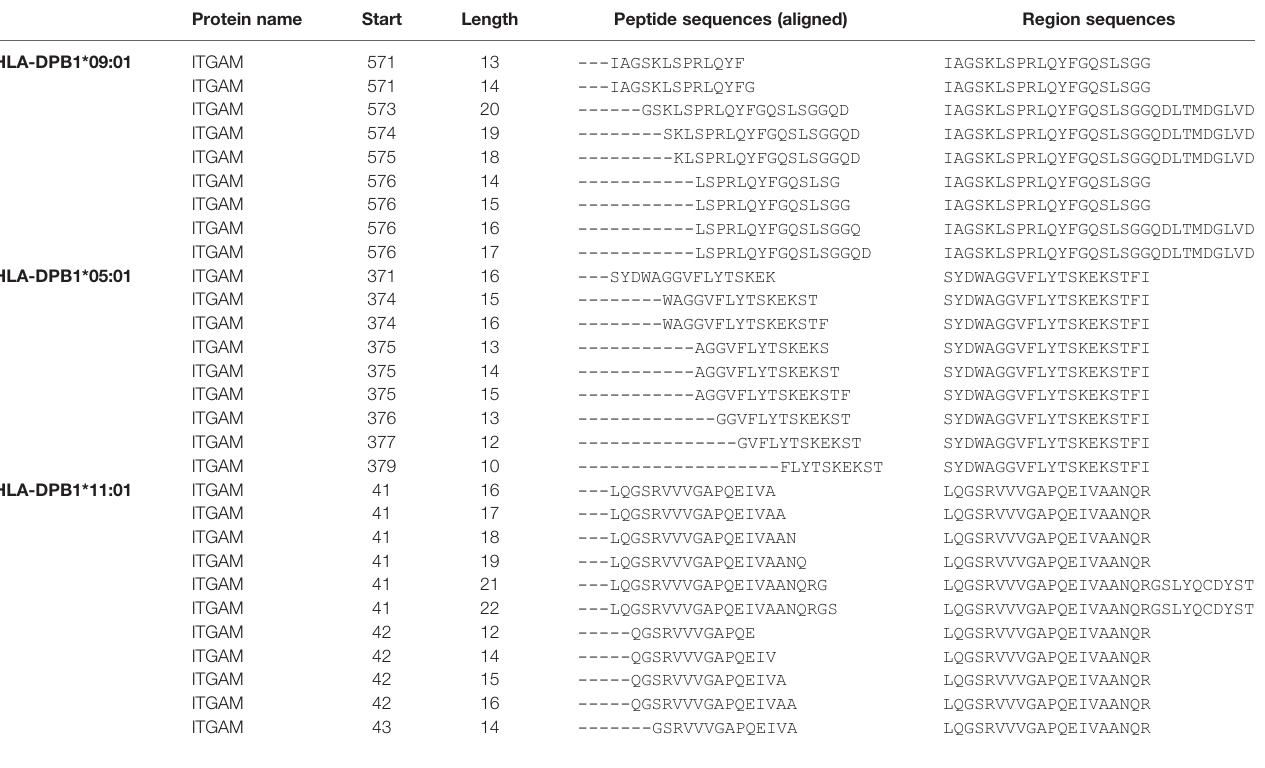
TABLE 1 | Examples of ITGAM peptides and their length variants and how the region sequences are identi fi